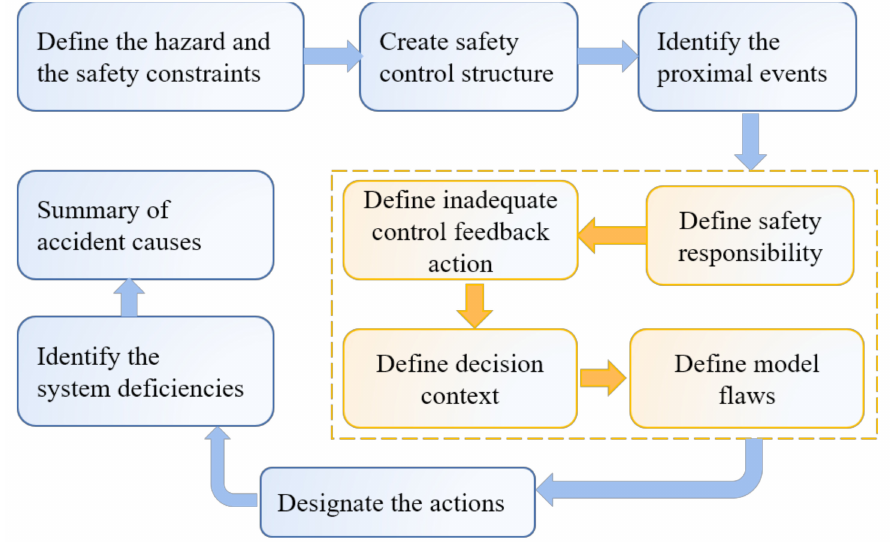
Figure 4. Flow chart of the